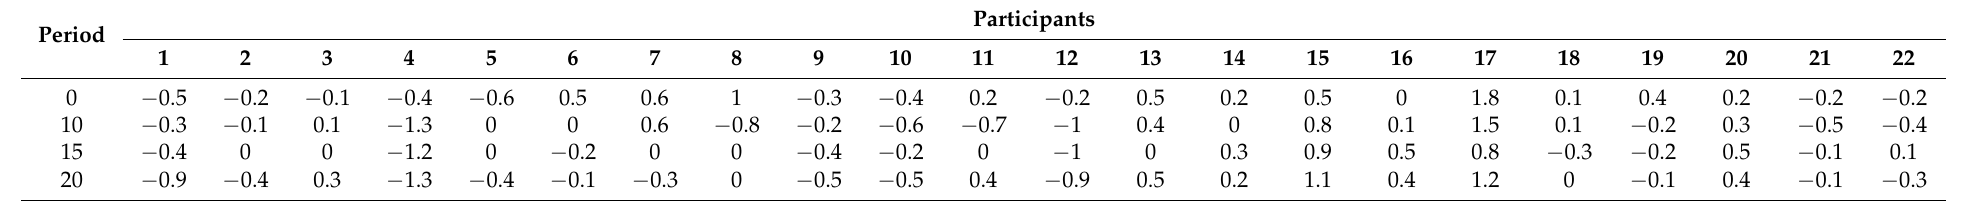
Table 6. Asymmetry analysis for infrared